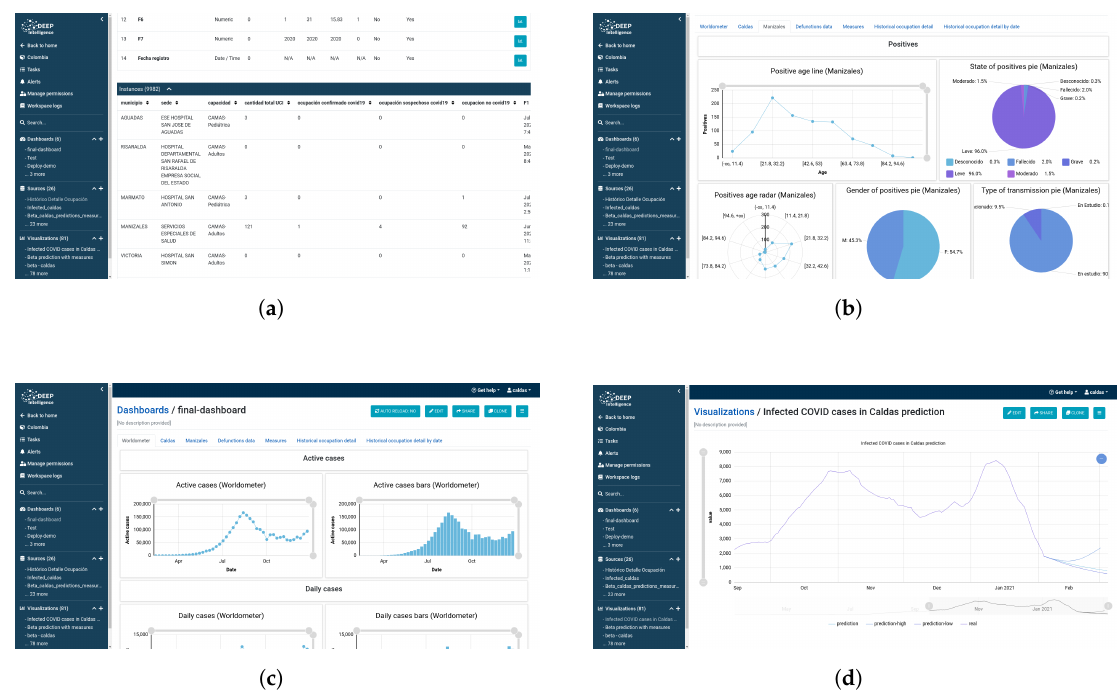
Figure 5. Some of the steps performed to build the system in Deep Intelligence [34]. ( a ) A data source in the platform, showing structured information. ( b ) Monitoring of additional indicators using the visualization tools provided by the platform. ( c ) Global curve visualization from an external source. ( d ) Visualization of the predictions obtained by the model.